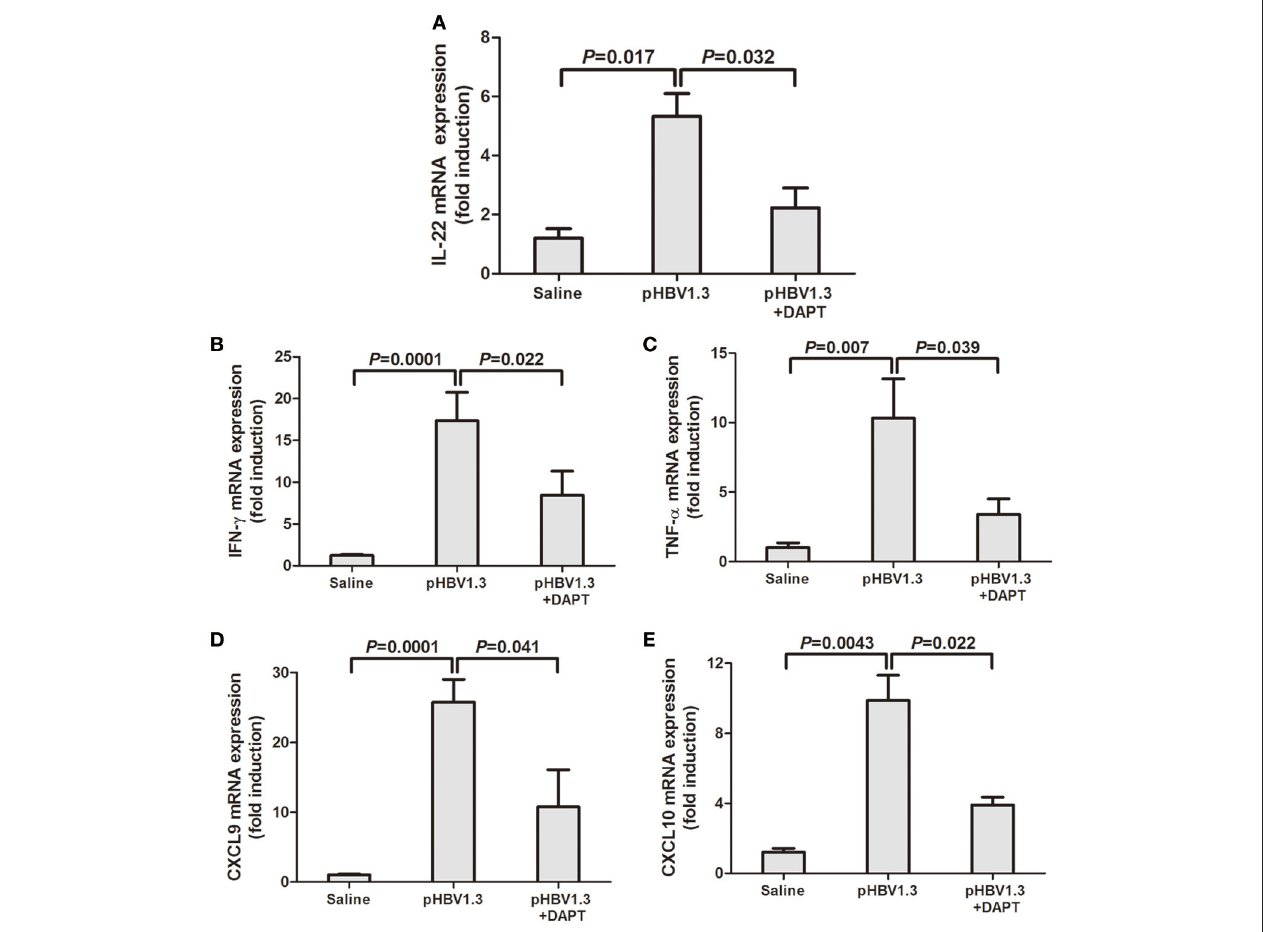
FIGURE 2 | Inhibition of Notch signaling reduced the HBV-induced elevation of IL-22, and related cytokines and chemokines mRNA expressions in the liver. mRNA expressions corresponding to IL-22 (A) , IFN- γ (B) , TNF- α (C) , CXCL9 (D) , and CXCL10 (E) in the livers were measured by PT-PCR. Results are displayed as fold differences relative to the saline injection group, and normalized to β